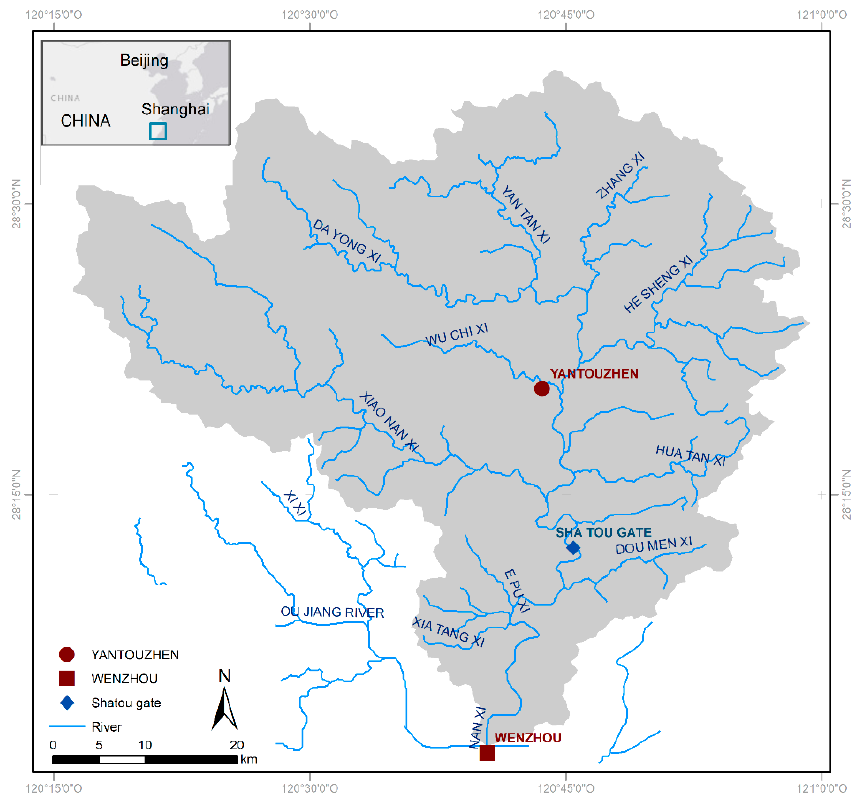
Figure 1. Nanxi river basin in Eastern China: watershed and main streams. Shatou Gate provides a barrier between freshwater and saltwater.